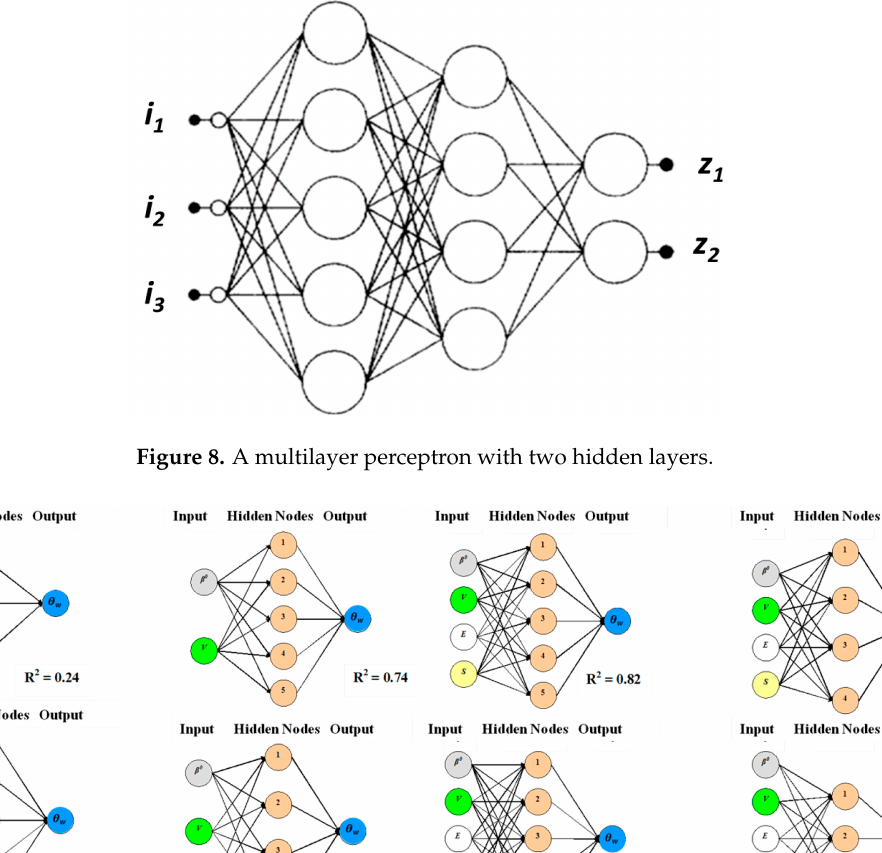
Table 3. Coefficient of determination (R 2 ) and cross validation coefficient of determination (CV R 2 ) of the neural networks based numerical models for soil moisture estimation.